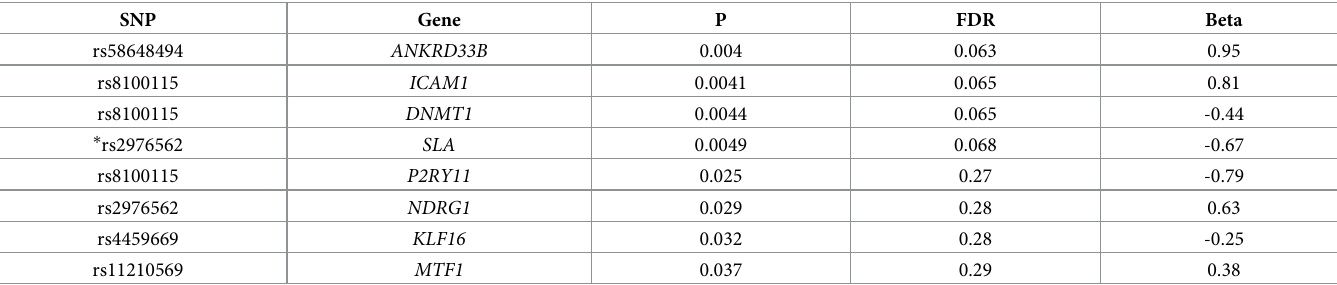
The p-value and beta is for the interaction between SNP and MTB stimulation and the gene column shows the gene for which the interaction is associated with expression * Indicates eQTL that was also significantly associated (P < 0.05 after FDR correction) with expression in MTB-stimulated cells (Fig